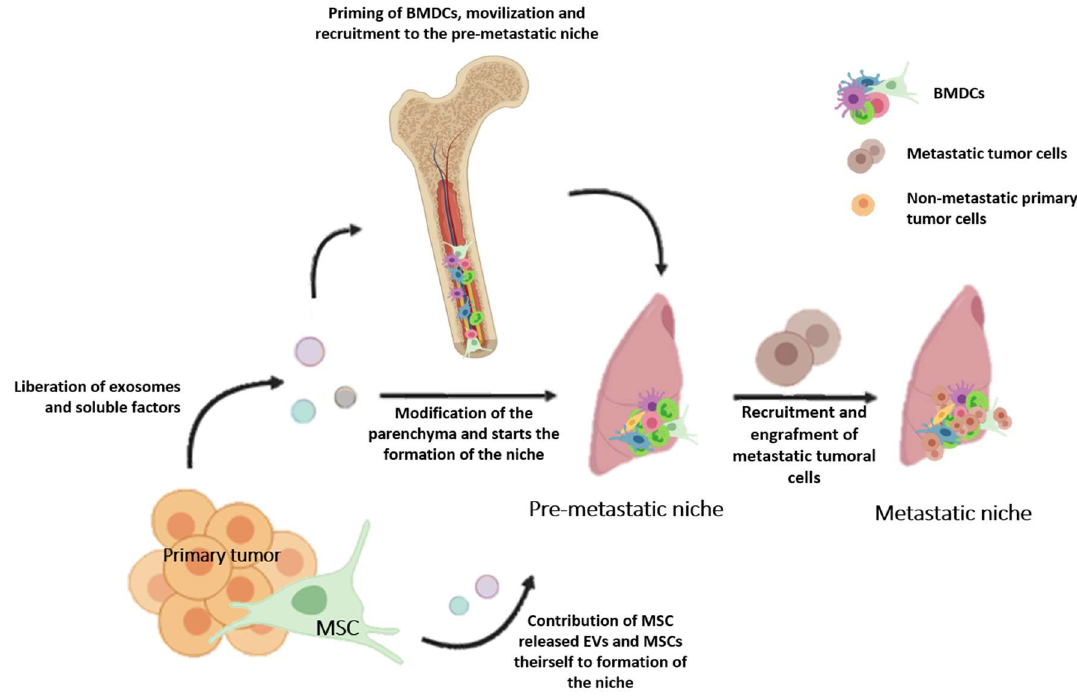
Figure 1. Representation of the steps necessary for the formation of the lung metastatic niche. Extracellular vesicles (EVs) and exosomes released by the primary tumor can directly modify the lung parenchyma or indirectly prime bone marrow derived cells (BMDCs) and recruit them into the lung pre-metastatic niche. MSCs also participates in this process by releasing EVs or migrating towards the inflammatory environment that the pre-metastatic niche represents. BMDCs (MSCs included) and enriched fibronectin environments may represent an attractive docking site for the disseminating tumor cells. Once metastatic tumoral cells are recruited and engrafted into the pre-metastatic niche, it allows for the formation of the lung metastatic niche.